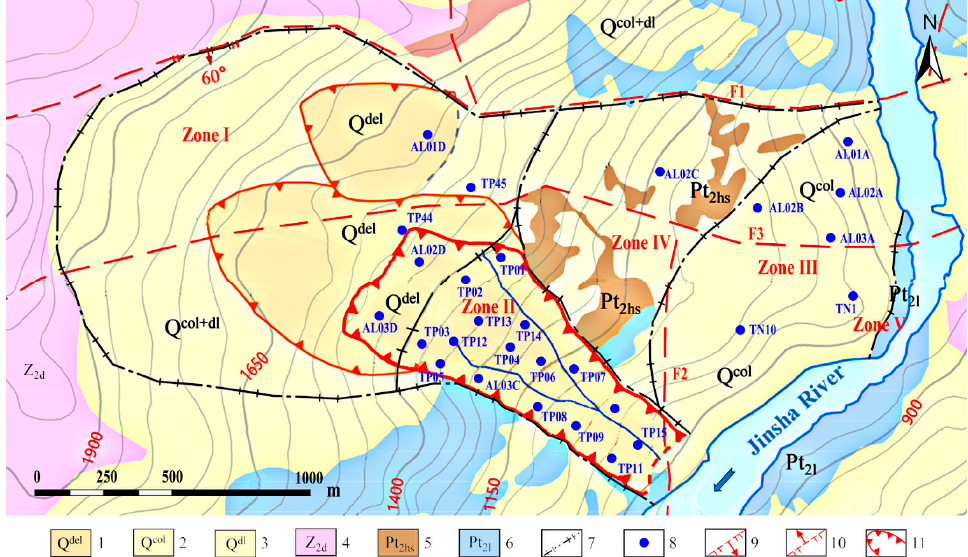
Figure 2. Topographic and lithological map of the Jinpingzi landslide. (1. Quaternary landslide deposit; 2. Quaternary colluvial deposit; 3. Quaternary slope deposit; 4. Upper Sinian dolomite; 5. Middle Proterozoic phyllite; 6. Middle Proterozoic dolomite; 7. Boundaries of landslide and zone areas; 8. GPS point; 9. Normal fault; 10. Reversed fault; 11. Active Zone II area).